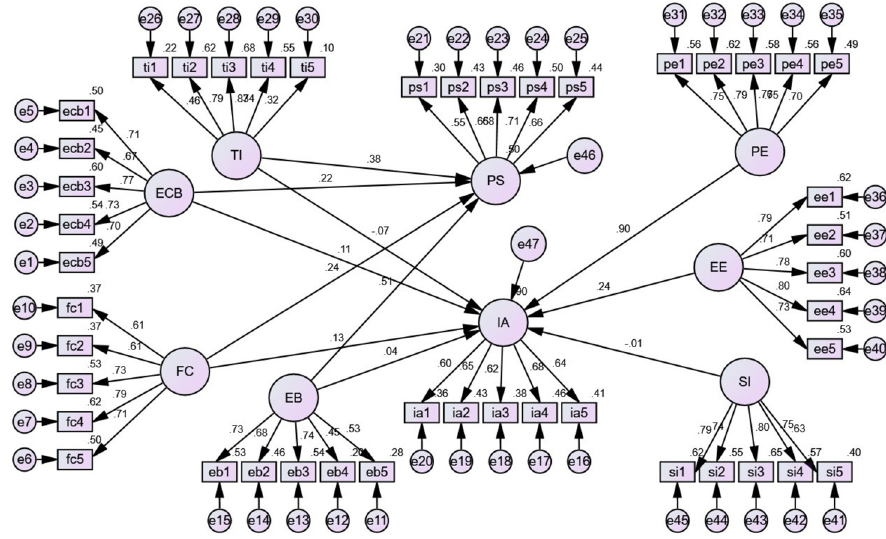
Figure 2. Summary of the PLS-SEM results.